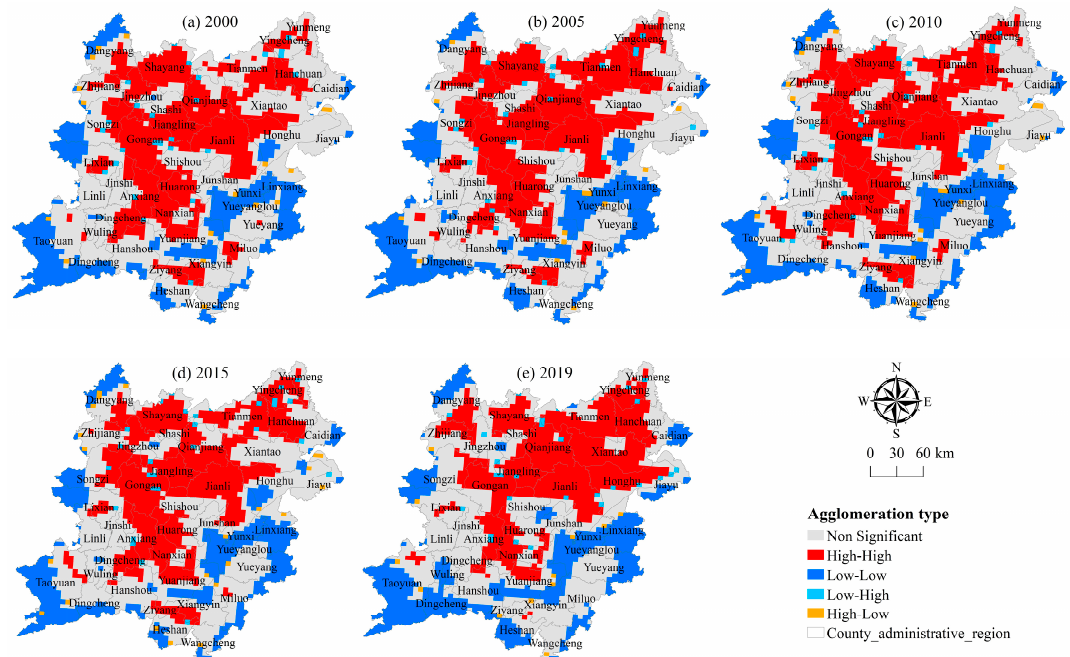
Figure 10. Local spatial autocorrelation diagram of CLSHI in the two lake plains from 2000 to 2019.